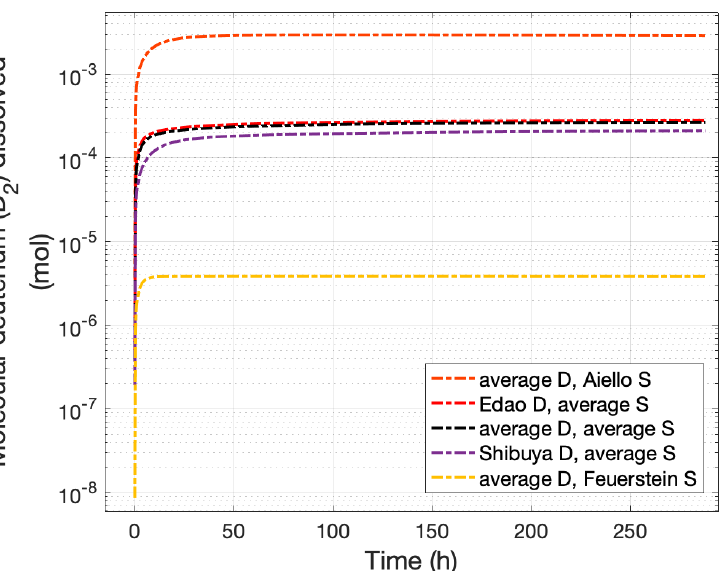
Figure 14. Impact of D Pb-Li and S Pb-Li on the amount of deuterium dissolved in Pb-Li. As before, D D initial gas pressure set to 780 mbar and BASE temperature set to 450 ◦ C. Averages diffusivity and Sieverts’ constant obtained using dissolution parameters introduced in Table 3; so curve in black is the same as the one presented in Figure 12a. Others are calculated applying dissolution parameters derived from literature [10,11,20,29]. Curves and respective legends displayed in the same descending order; line colors in agreement with Figure